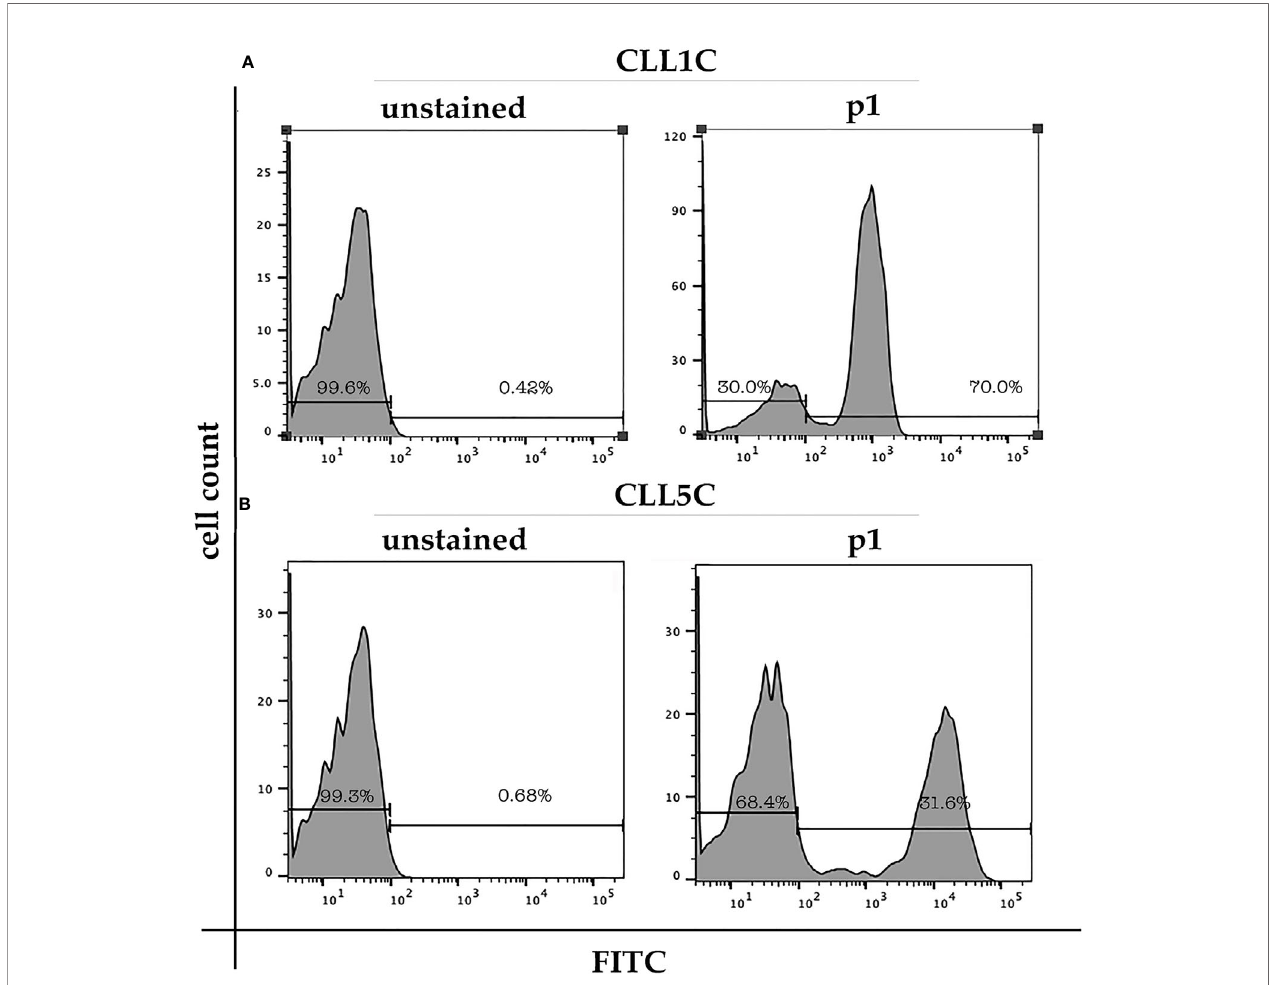
FIGURE 2 | CD19/CD5 positive B-CLL cells isolated from CLL1C (month 8, panel A ) and CLL5C (month 24, panel B ) patients were stained with FITC- conjugated peptide p1 or unstained. p1-positive cells corresponding to the VH 1-69 clones were 70% of total B-CLL population in CLL1C patient and 32% in CLL5C